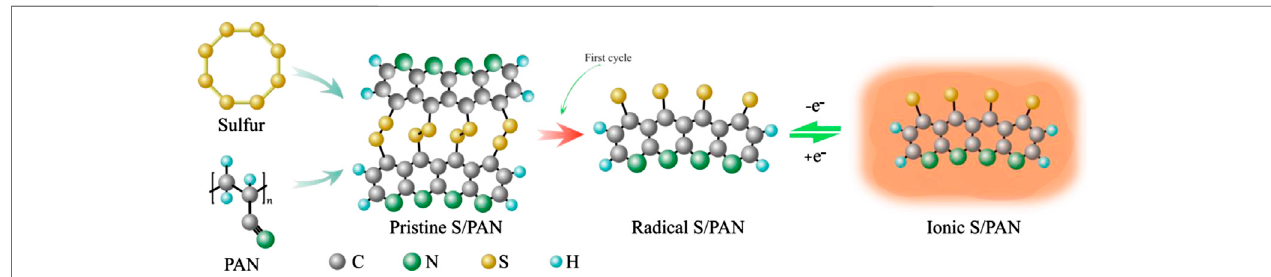
FIGURE 1 | S/PAN reaction mechanism with radical and ionic intermediates. Adapted with premission from Wang et al. (2018). Copyright (2018) American Chemical Society.